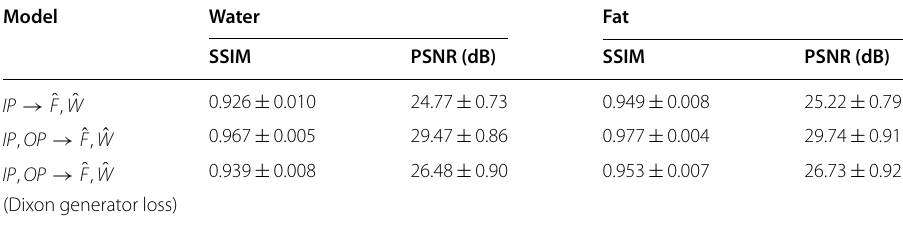
Values reported are the average and standard